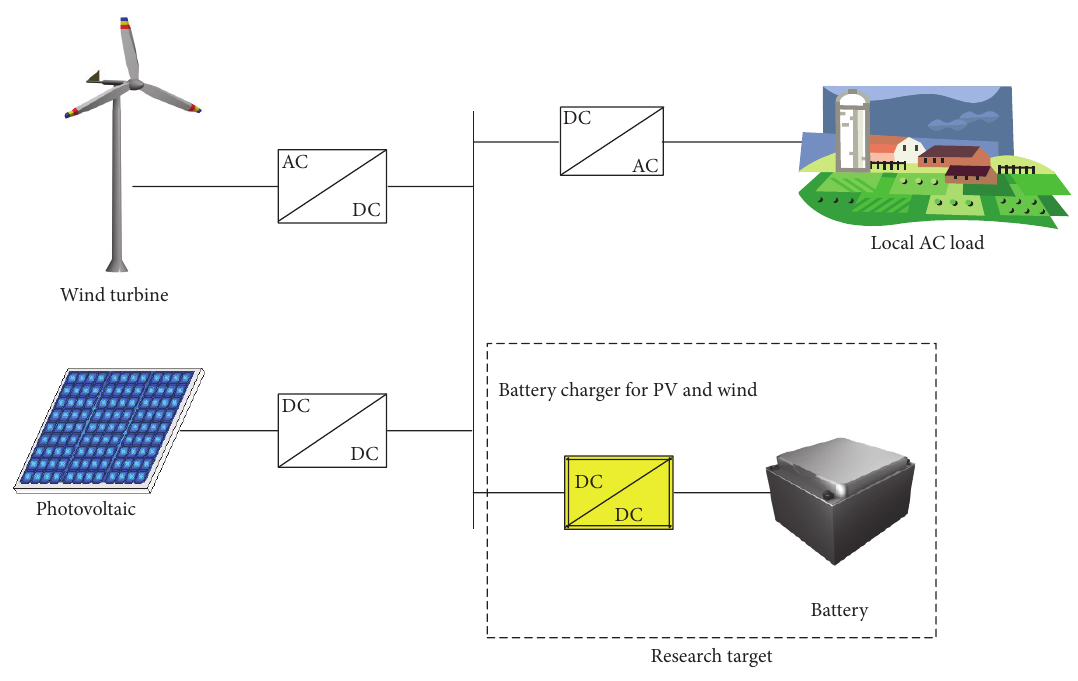
Figure 2: Standalone micropower grid configuration.